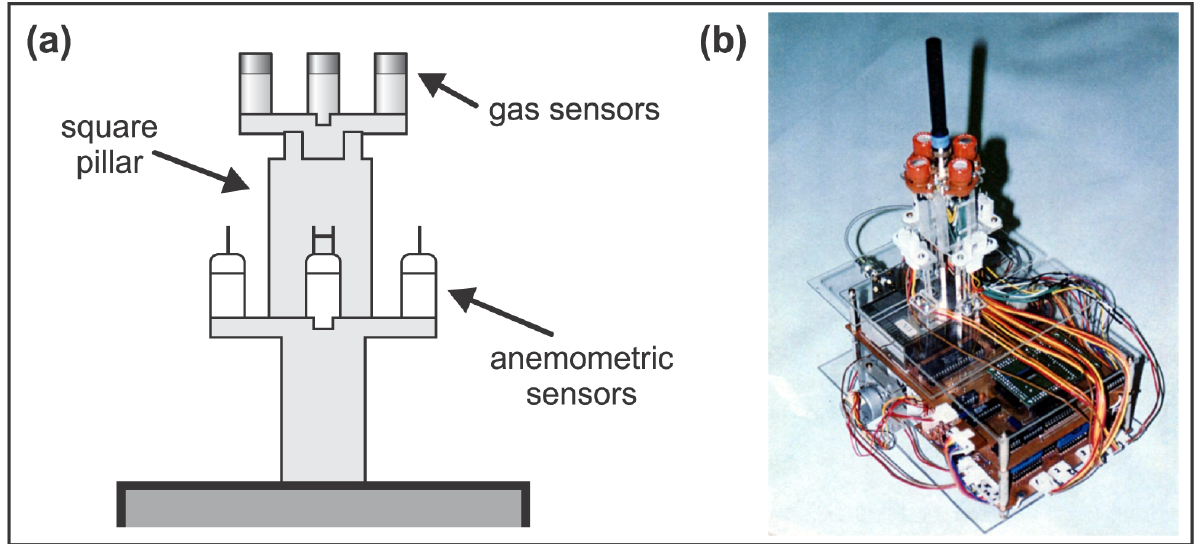
Figure 11 . Sensor probe used in the experiments of Ishida et al. [76], which consists of four thermistor anemometric sensors and four metal oxide gas sensors. (a) Sketch of the probe, adapted from [76]. (b) Mobile robot carrying the sensor probe (photograph by courtesy of Hiroshi